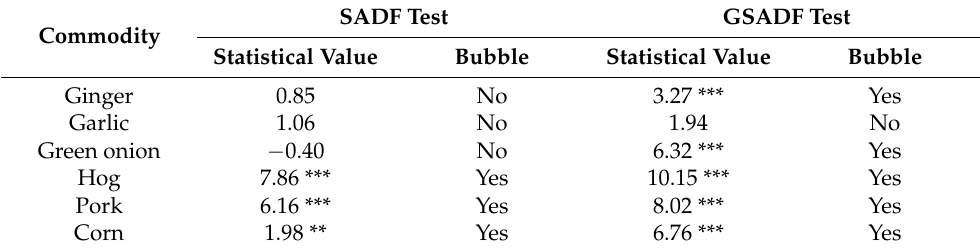
Table 2. Results of the agricultural commodity price bubble tests. SADF Test GSADF Test Commodity Statistical Value Bubble Statistical